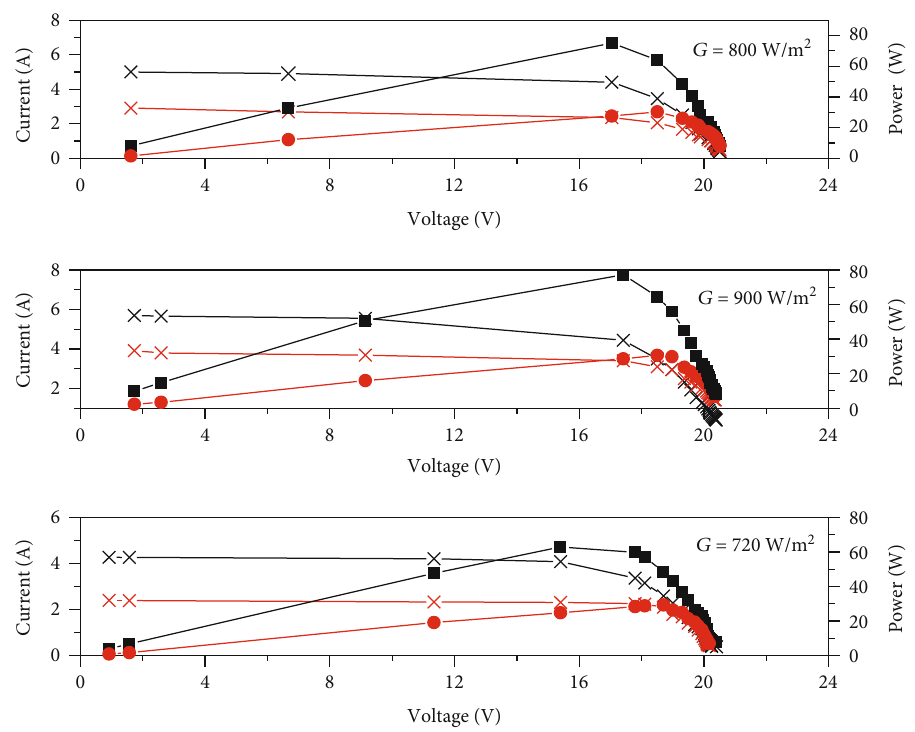
Figure 8: I ‐ V and P ‐ V curves are represented in thin and bolded lines, respectively, while black and red colours represent clean and dirty modules, respectively (with 20-45 μ m coal